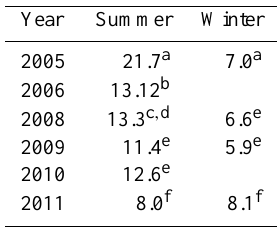
Table 1. The sum of formaldehyde and acetaldehyde concentrations in Beijing